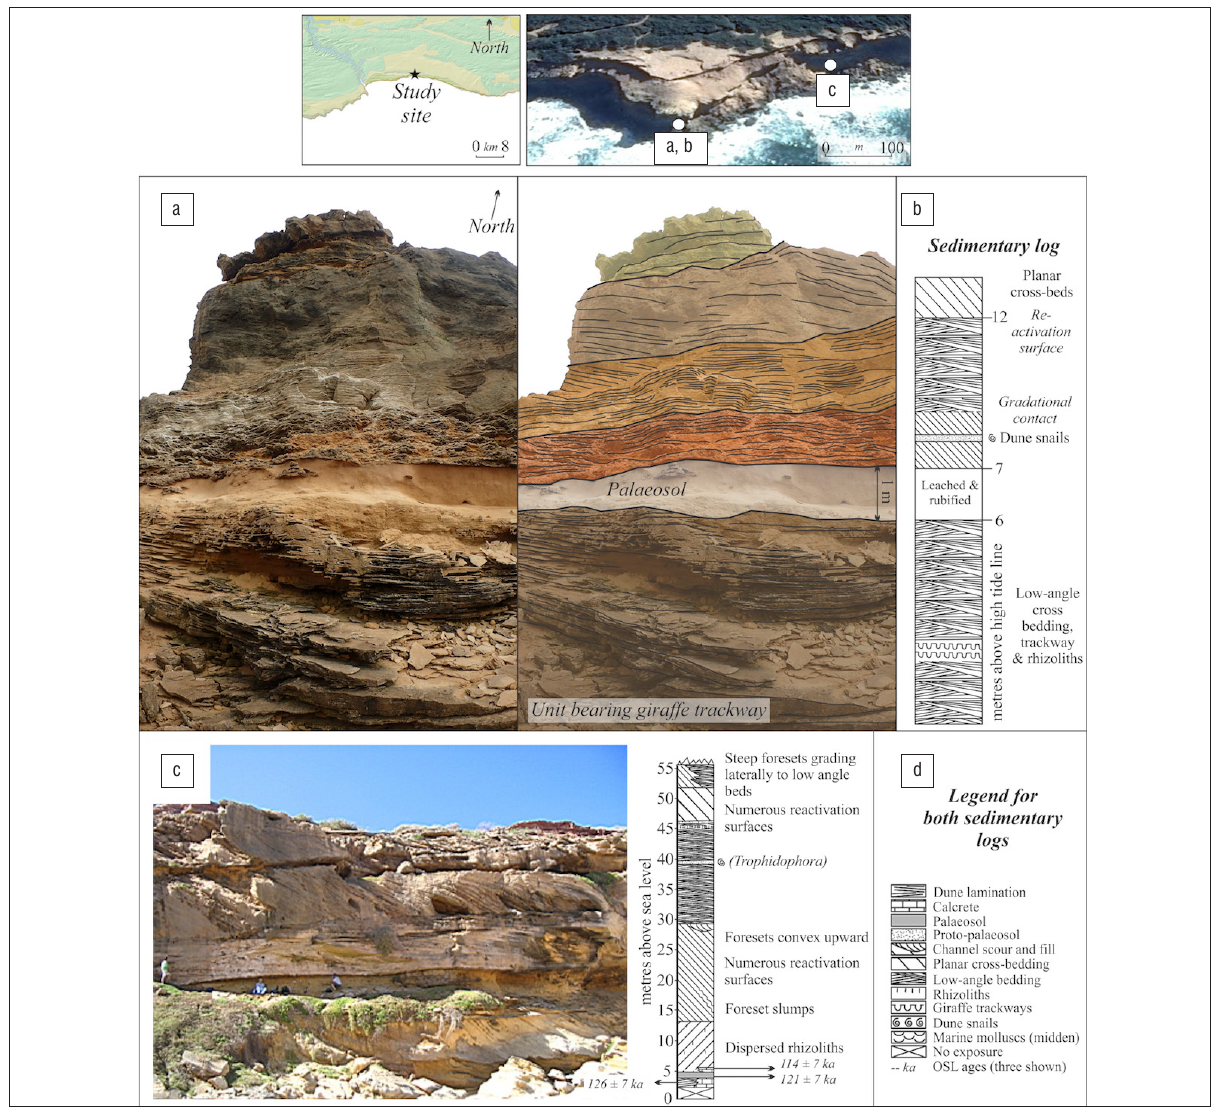
Figure 2: A comparison of the geological section investigated for this work and the known and dated stratigraphy from the region. (a, b) Annotated photograph and logged section for this work. (c) Sedimentary log and photograph of context from Roberts et al. 2 (d) Legend for the symbols and structures shown on both sedimentary logs.